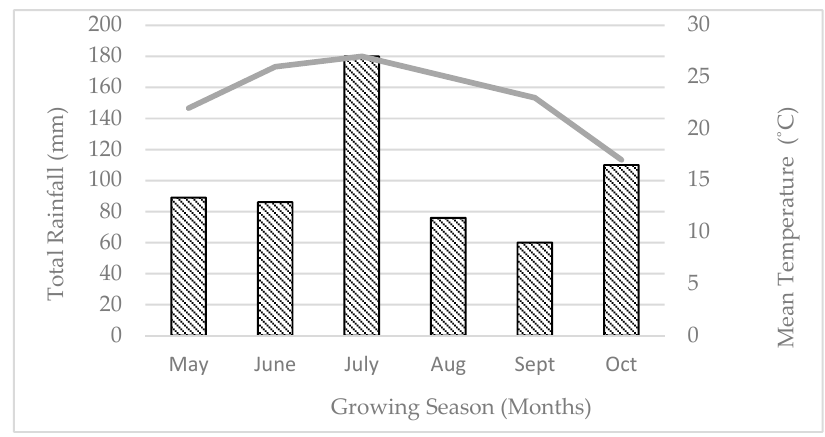
Figure 1. Monthly average climate data (source: usclimatedata.com).